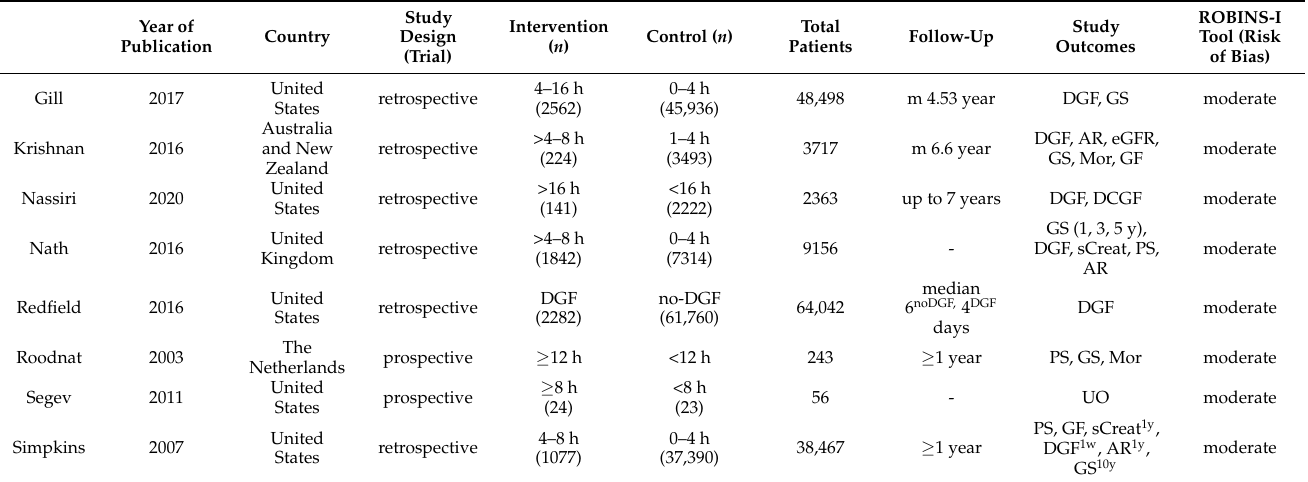
Table 1. Overview of the included studies in the systematic review.